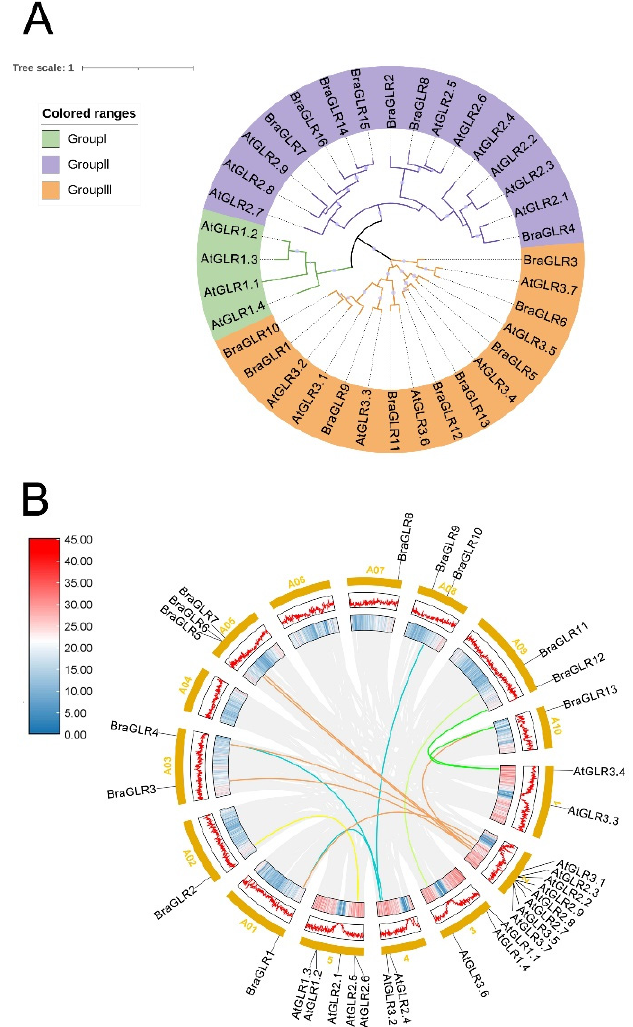
Figure 1. Phylogenetic relationships and synteny analysis of GLR genes between B. rapa and A. thaliana . ( A ) Phylogenetic relationships. ( B ) Synteny analysis. The curves of green, orange, yellow green, blue, and yellow link the GLR genes on the Chr1, Chr2, Chr3, Chr4, and Chr5 chromosomes of A. thaliana and orthologous genes in B. rapa ,